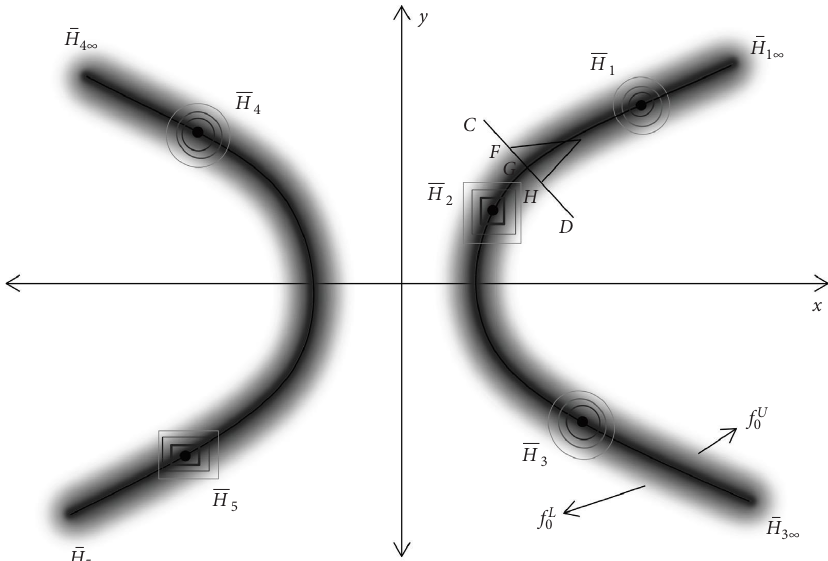
Figure 2: Fuzzy hyperbola (towards completing the fuzzy hyperbola in Figure